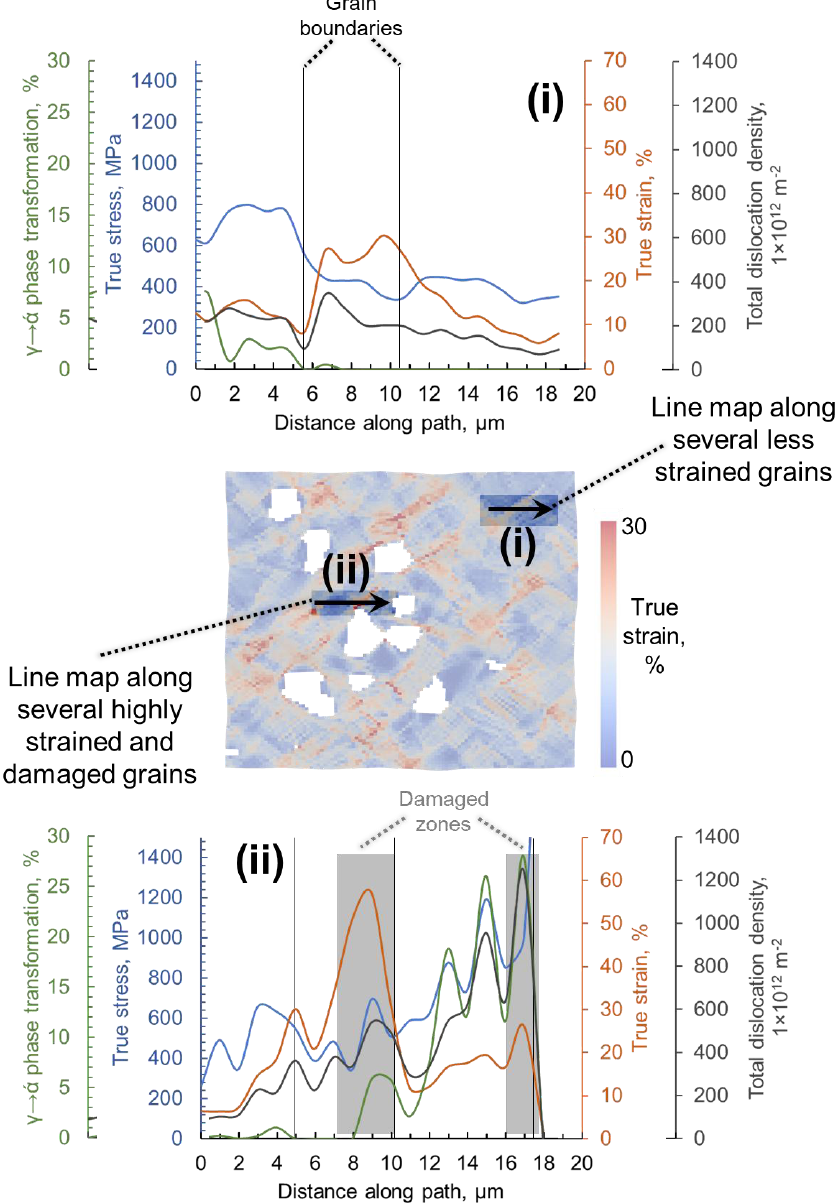
Figure 8. Line distribution of local attributes across the grain boundaries in ( i ) free zone and ( ii ) interlocked zone.